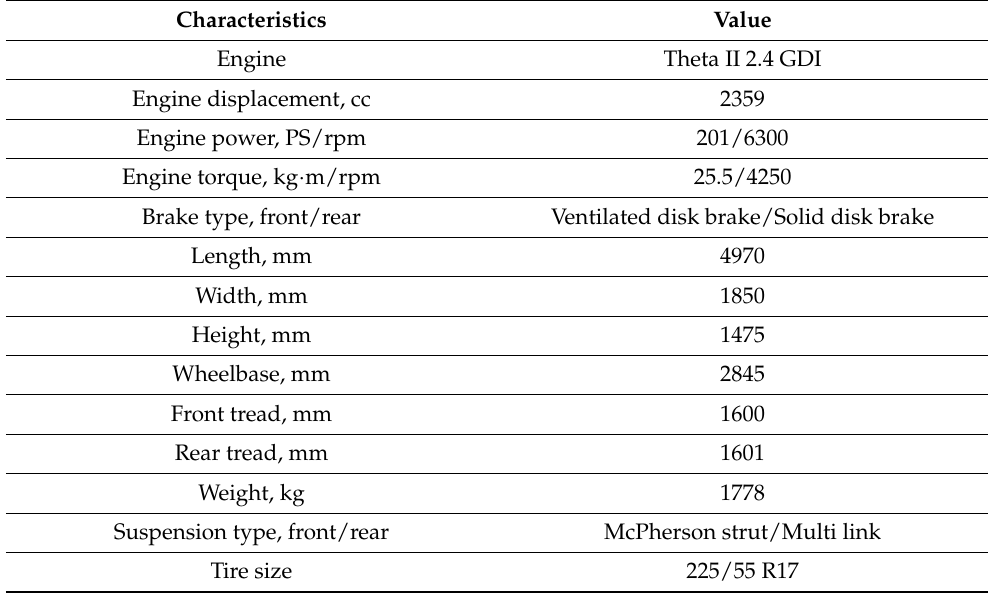
Table 1. Target vehicle’s specifications [14].